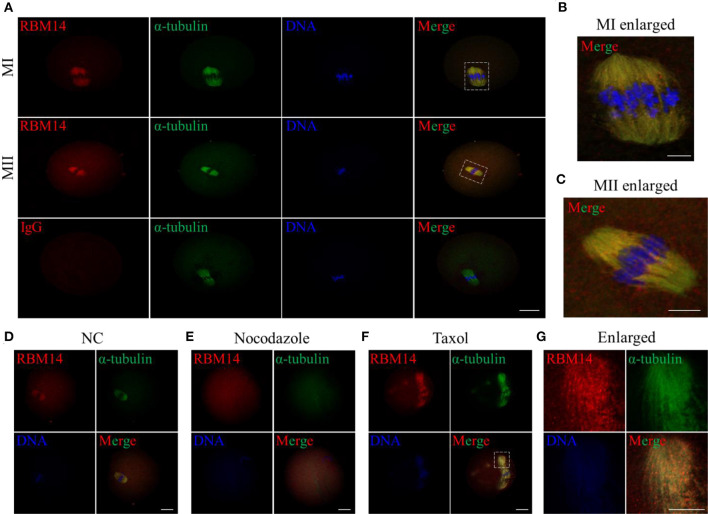
Localization of RBM14 in mouse oocytes treated with spindle-perturbing agents (nocodazole or taxol). (A) Immunofluorescence staining: red = RBM14 antibody, green = α-tubulin-FITC antibody, blue = DNA (Hoechst 33342). Representative images showing MI- and MII-stage oocytes. RBM14 signals were mainly distributed on spindle microtubules and presented a similar localization pattern to α-tubulin. The dotted boxes indicate the enlarged areas. No obvious signals were detected in the negative control (IgG antibody). Scale bar = 20 μm. (B) Magnified images of the white dotted box in (A), MI-stage oocytes. Red = RBM14 antibody; green = α-tubulin-FITC antibody; blue = DNA (Hoechst 33342). Scale bar = 5 μm. (C) Magnified images of the white dotted box in (A), MII-stage oocytes. Red = RBM14 antibody; green = α-tubulin-FITC antibody; blue = DNA. Scale bar = 5 μm. (D–F) MI-stage oocytes treated with nocodazole or taxol: red = RBM14 antibody, green = α-tubulin-FITC antibody, blue = DNA (Hoechst 33342). The dotted box indicates the enlarged area. Scale bars = 20 μm. (G) Magnified images of the white dotted box in (F), MI-stage oocytes treated with taxol. Red = RBM14 antibody; green = α-tubulin-FITC antibody; blue = DNA (Hoechst 33342). Scale bar = 10 μm.